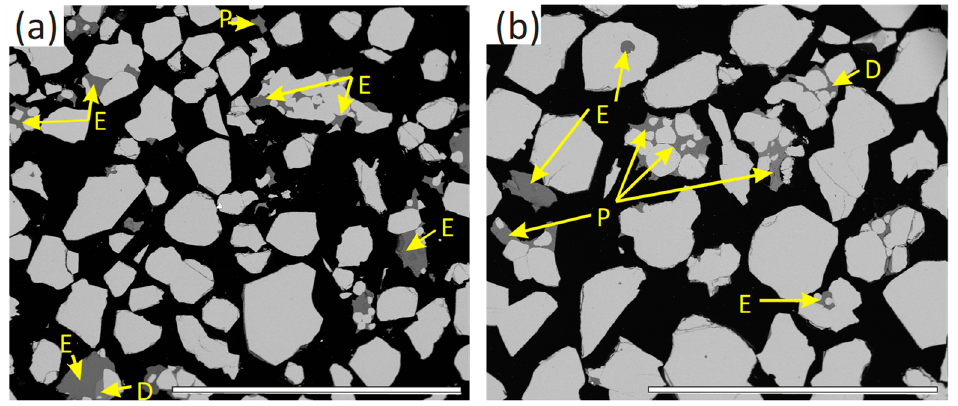
Figure 2. BSE images of ( a ) the − 2 mm bulk sample and ( b ) the − 600 +425 µ m fraction. Key to symbols: E = enstatite, P = plagioclase (anorthite-rich), and D = diopside. The bright grains in both images are chromite-rich spinels. The scale bar in each image represents a size of 2.0 mm.